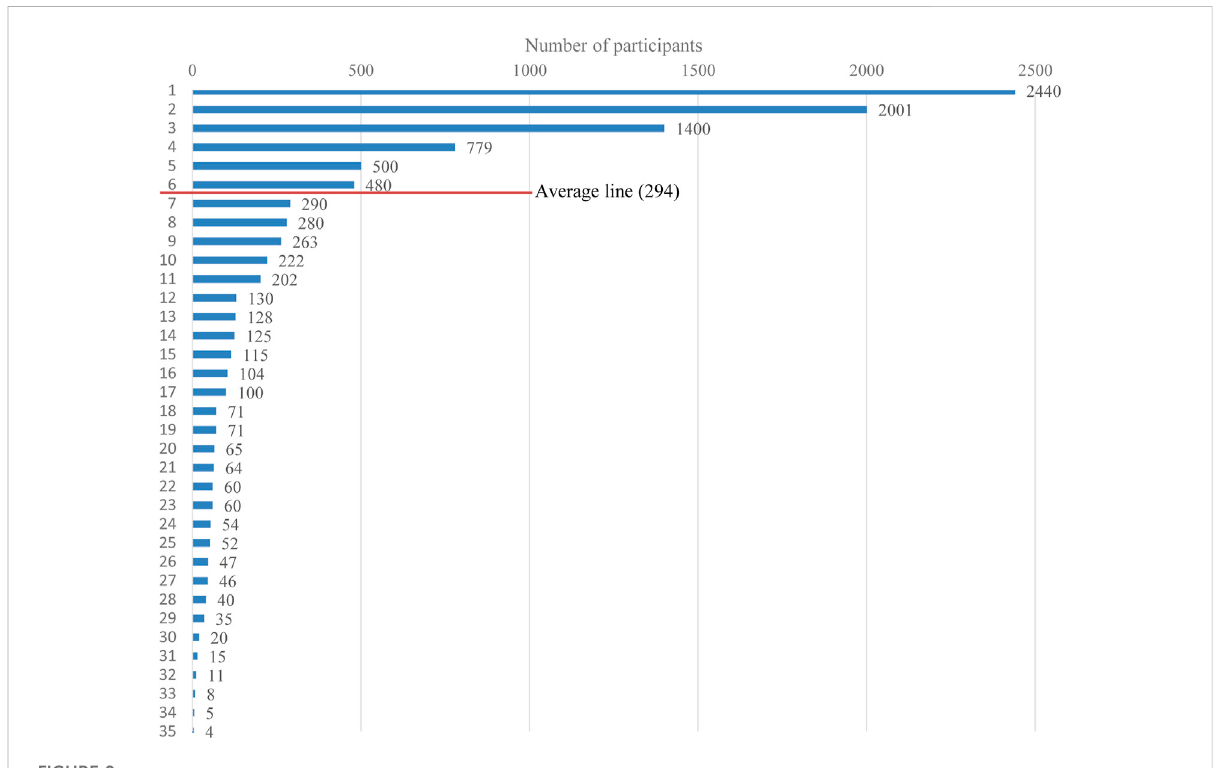
FIGURE 9 Number of participants of the publications